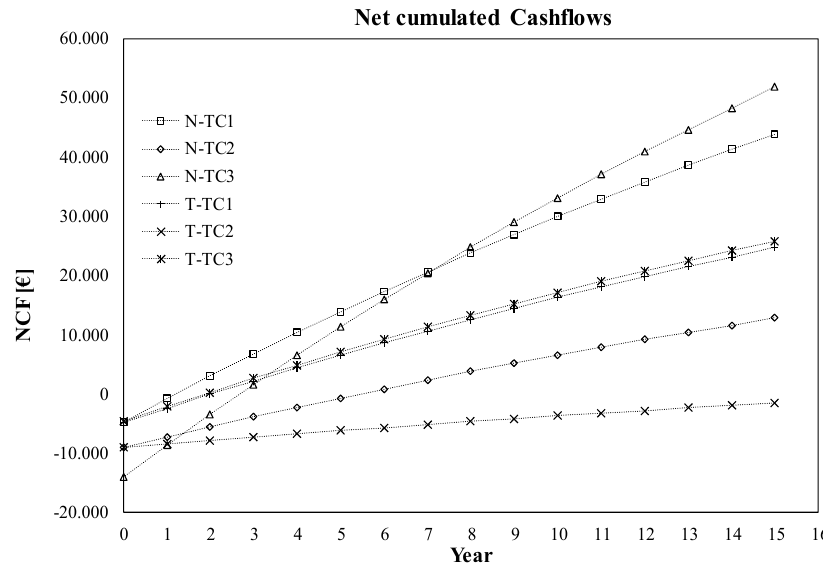
Figure 4. Actualized cumulated cash flows generated by all scenarios.